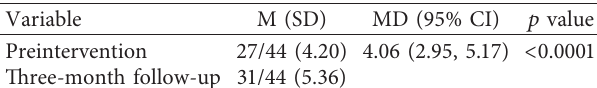
Table 3: Paired t -test at preintervention and postintervention.